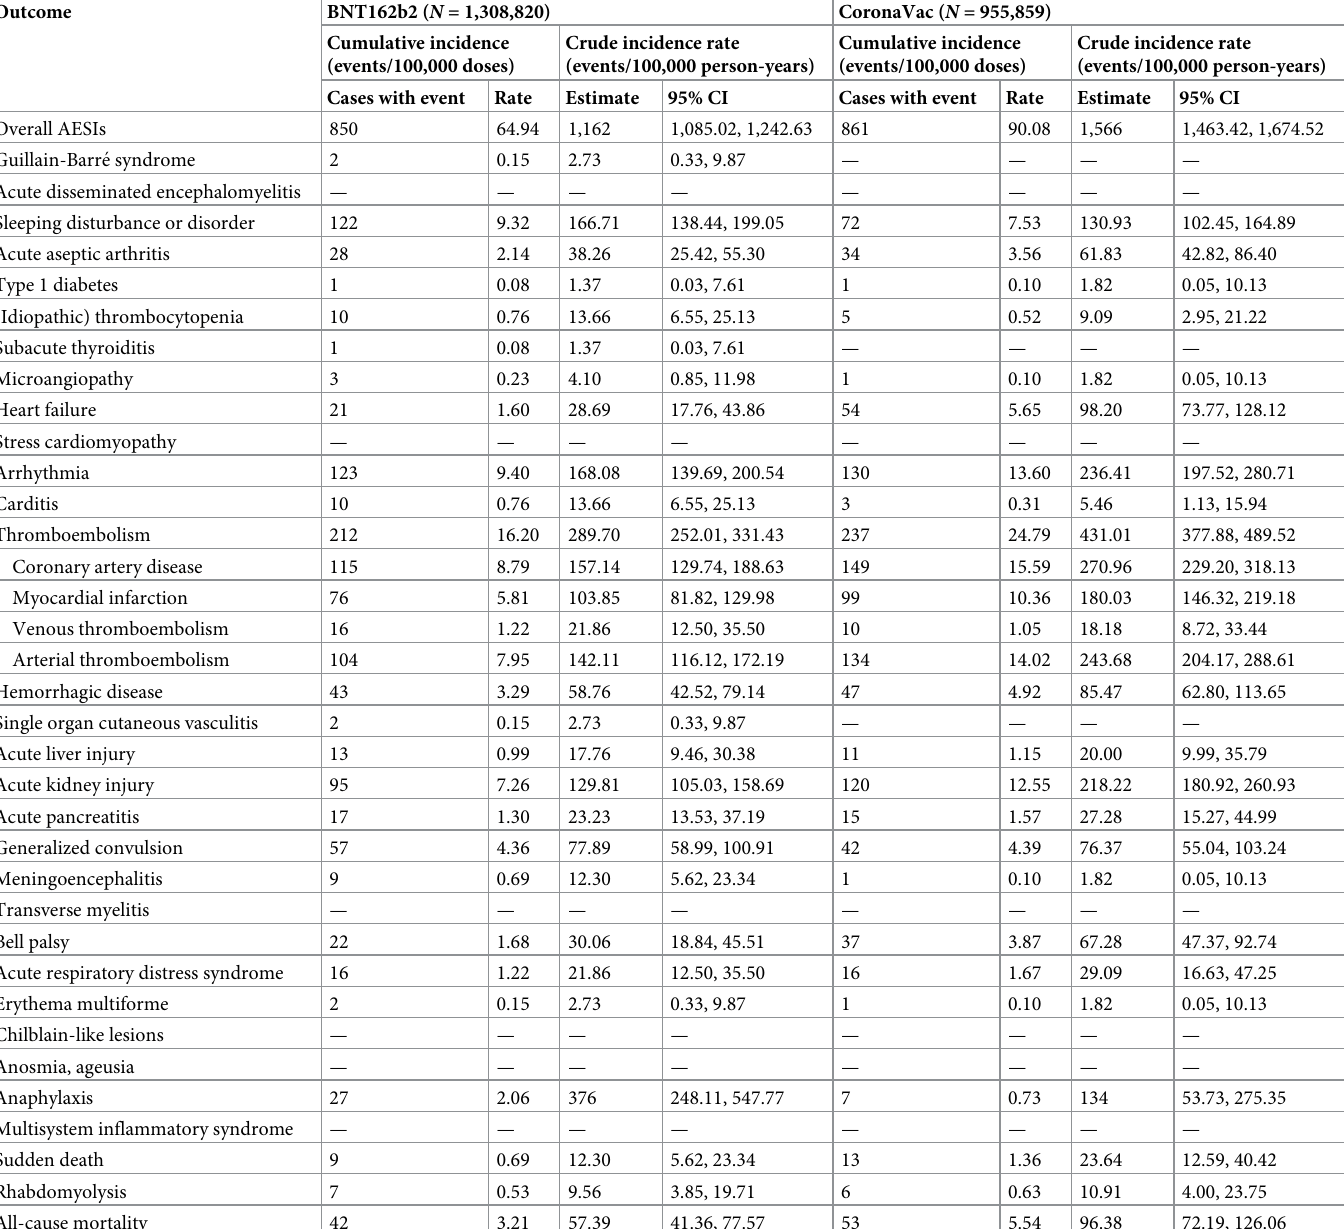
Table 2. Cumulative incidence and crude incidence rate of AESIs among first dose recipients of CoronaVac or BNT162b2 from 23 February to 9 September 2021 in Hong Kong SAR, China.